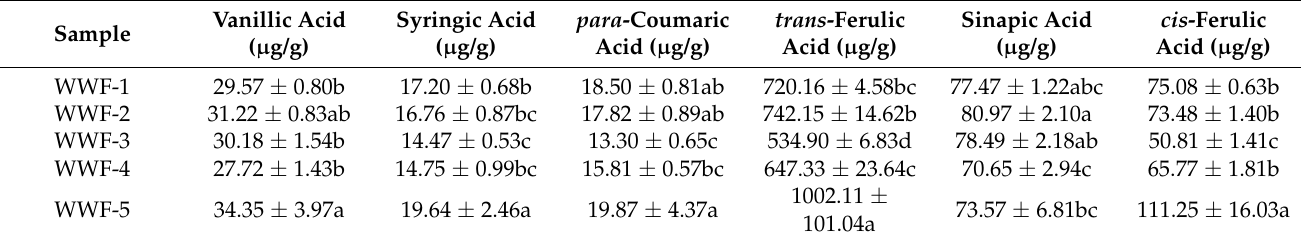
Table 2. Phenolic acid composition of WWFs obtained by different milling